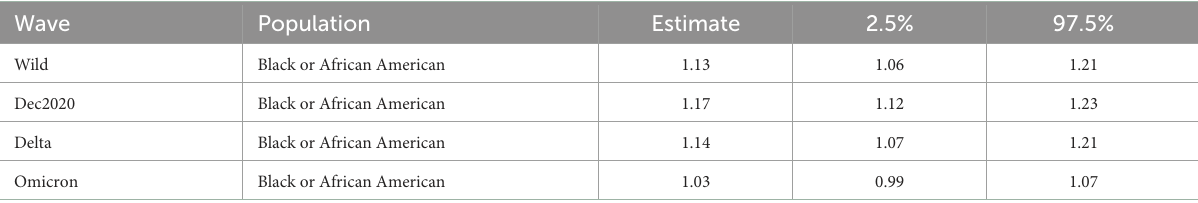
TABLE 4 Table shows the risk ratio of length of stay (LoS) for Black inpatients as compared with White inpatients.